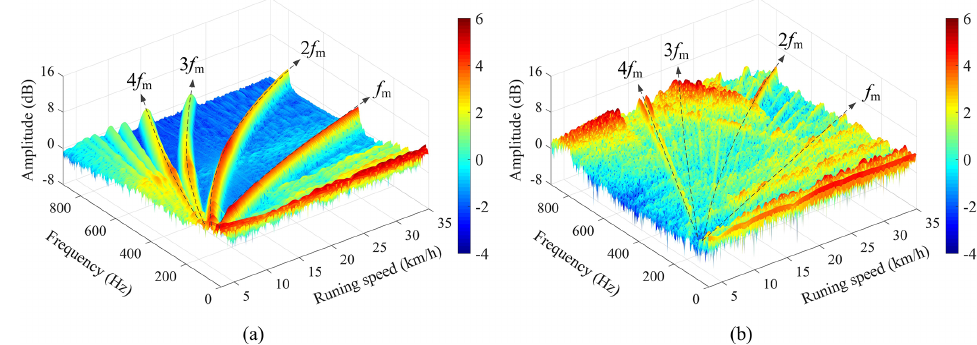
Figure 9. Time–frequency distribution of the traction motor vibration responses: (a) simulated results, (b) field test results.